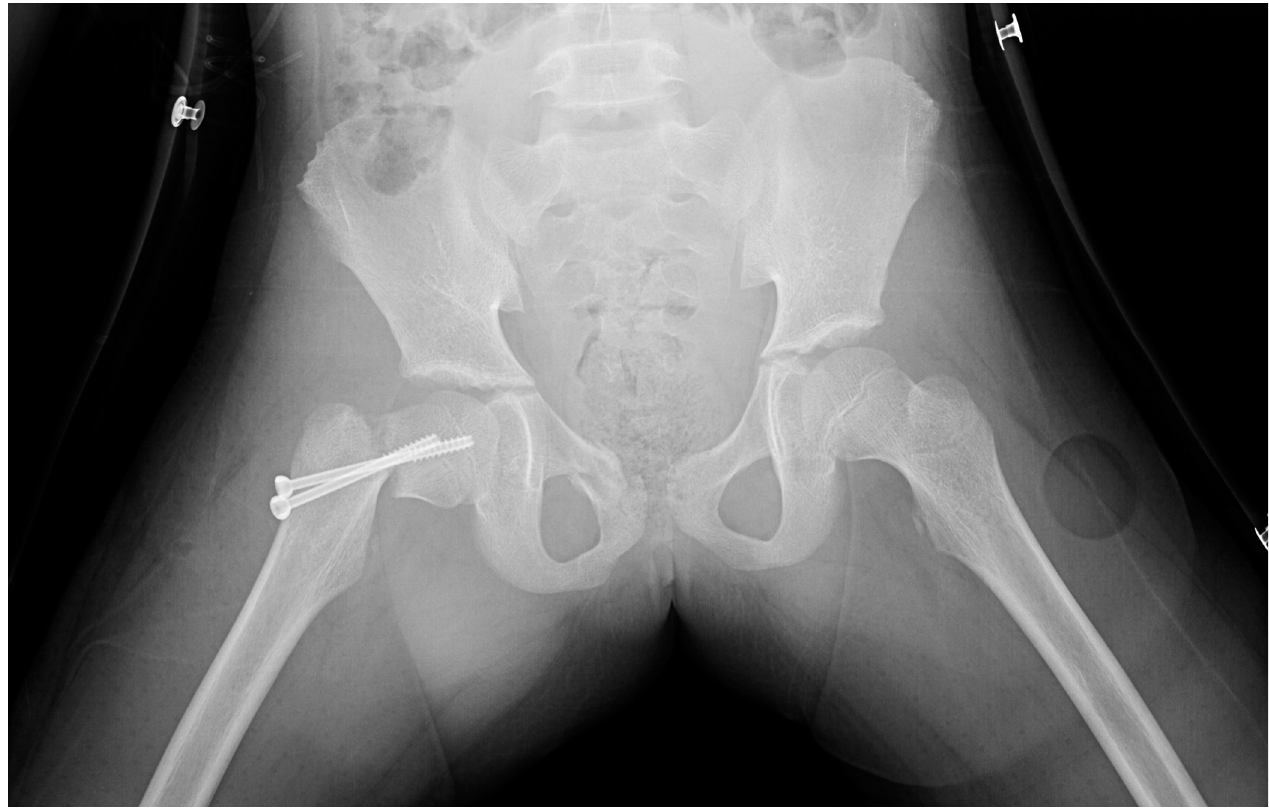
Fig 2. Reduction quality. Unsatisfactory reduction: The widest distance of the fracture ends is obvious (more than 10mm); the diaphragm is poorly aligned (more than 10˚).